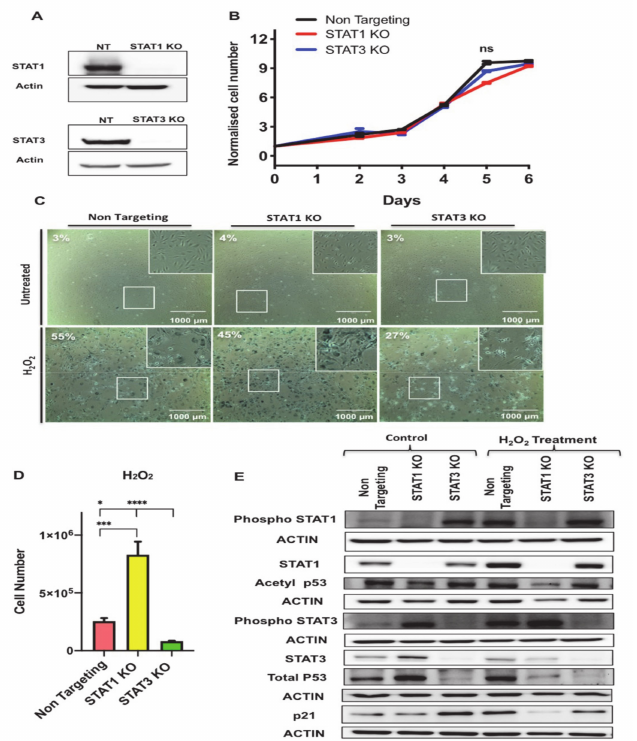
Figure 7. Antagonistic functions of STAT1 and STAT3 in regulating growth arrest and cell survival phenotypes in senescent preadipocytes. ( A ) Western blot assessing the protein levels of STAT1 and STAT3 in control NT, STAT1 KO, STAT3 KO cells. Actin was used as loading control. ( B ) Growth curve analysis of untreated non-targeting (NT), STAT1 KO, and STAT3 KO preadipocytes. The number of live preadipocytes in each condition was counted on different days and represented as a fold-increase over the number of seeded preadipocytes on Day-1. Results are presented as means ± SEM of three independent experiments. ( C ) Senescence-associated β -galactosidase (SA- β -gal) staining of proliferating (untreated) or H 2 O 2 treated non-targeting (NT), STAT1 KO, and STAT3 KO preadipocytes. SA- β -gal positive preadipocytes were quantified from four different fields and represented as a percentage as indicated within the images. Scale bar: 1000 µ m. ( D ) Graph represents the count of cell number of NT, STAT1 KO, and STAT3 KO following H 2 O 2 treatment protocol. Results are presented as means ± SEM of three independent experiments. * p ≤ 0.05, *** p ≤ 0.001, **** p ≤ 0.0001 (ANOVA with post-hoc Tukey test). ( E ) Western blot of phospho-STAT1 (Y701), STAT1, phospho-STAT3 (Y705), STAT3, acetylated p53 (Lys375), total p53, p21 in untreated NT, STAT1 KO, and STAT3 KO preadipocytes vs. H 2 O 2 treated counterparts as indicated. Actin was used as loading control. Results are represented as means ± SEM from three independent